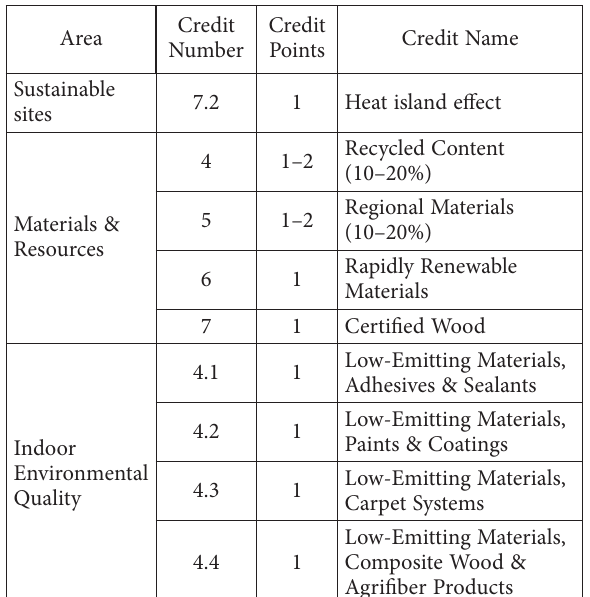
Table 1. Credits of Material Selection according to LEED Rating System (USGBC,